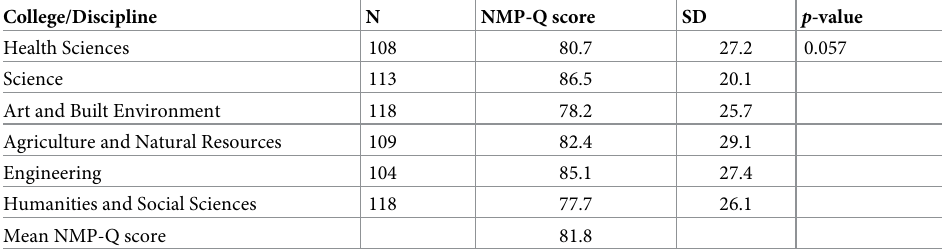
Table 4. Nomophobia scores for colleges/disciplines (N = 670).